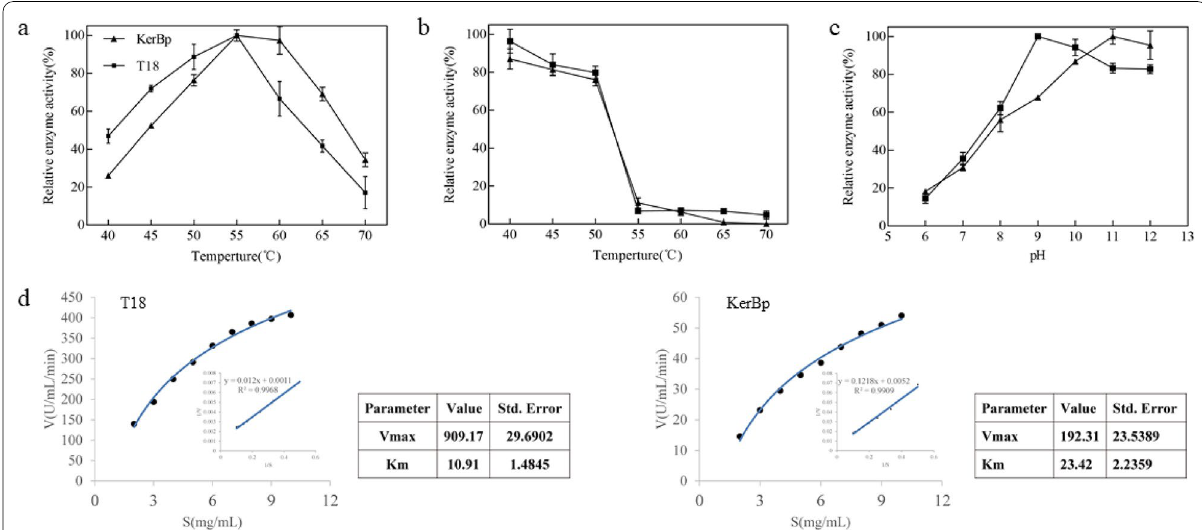
Fig. 2 Enzymatic properties of variant T18. a Optimum temperature; b thermal stability; c optimum pH; d steady‑state kinetic analysis